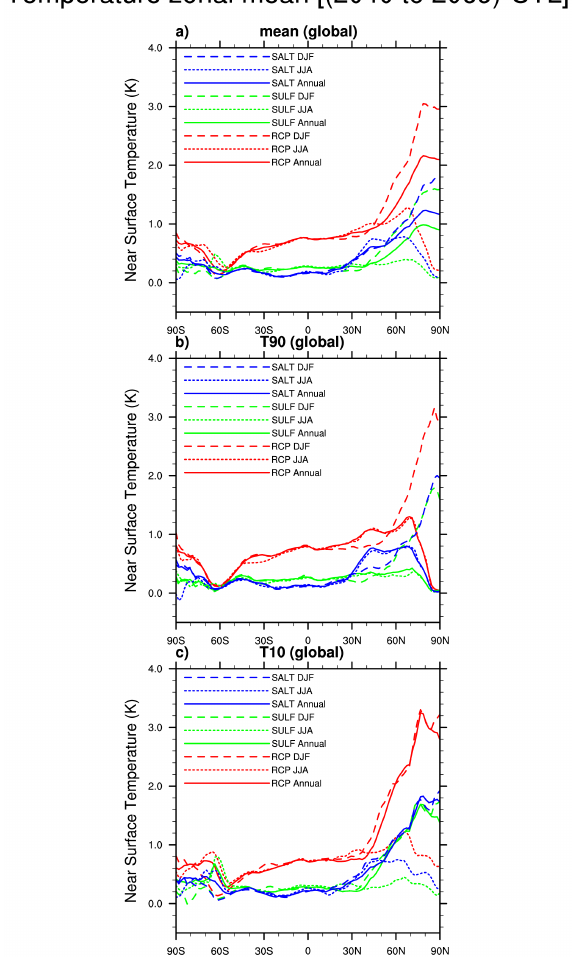
Figure 7. Multi-model zonal mean changes in temperature (K) of RCP4.5 (red), SALT (blue) and SULF (green) for the 2040–2069 period minus the RCP4.5 2006–2035 control period (CTL) for an- nual mean, DJF and JJA. The top panel shows changes in mean val- ues, middle panel for the 90th percentile values and bottom panel for the 10th percentile